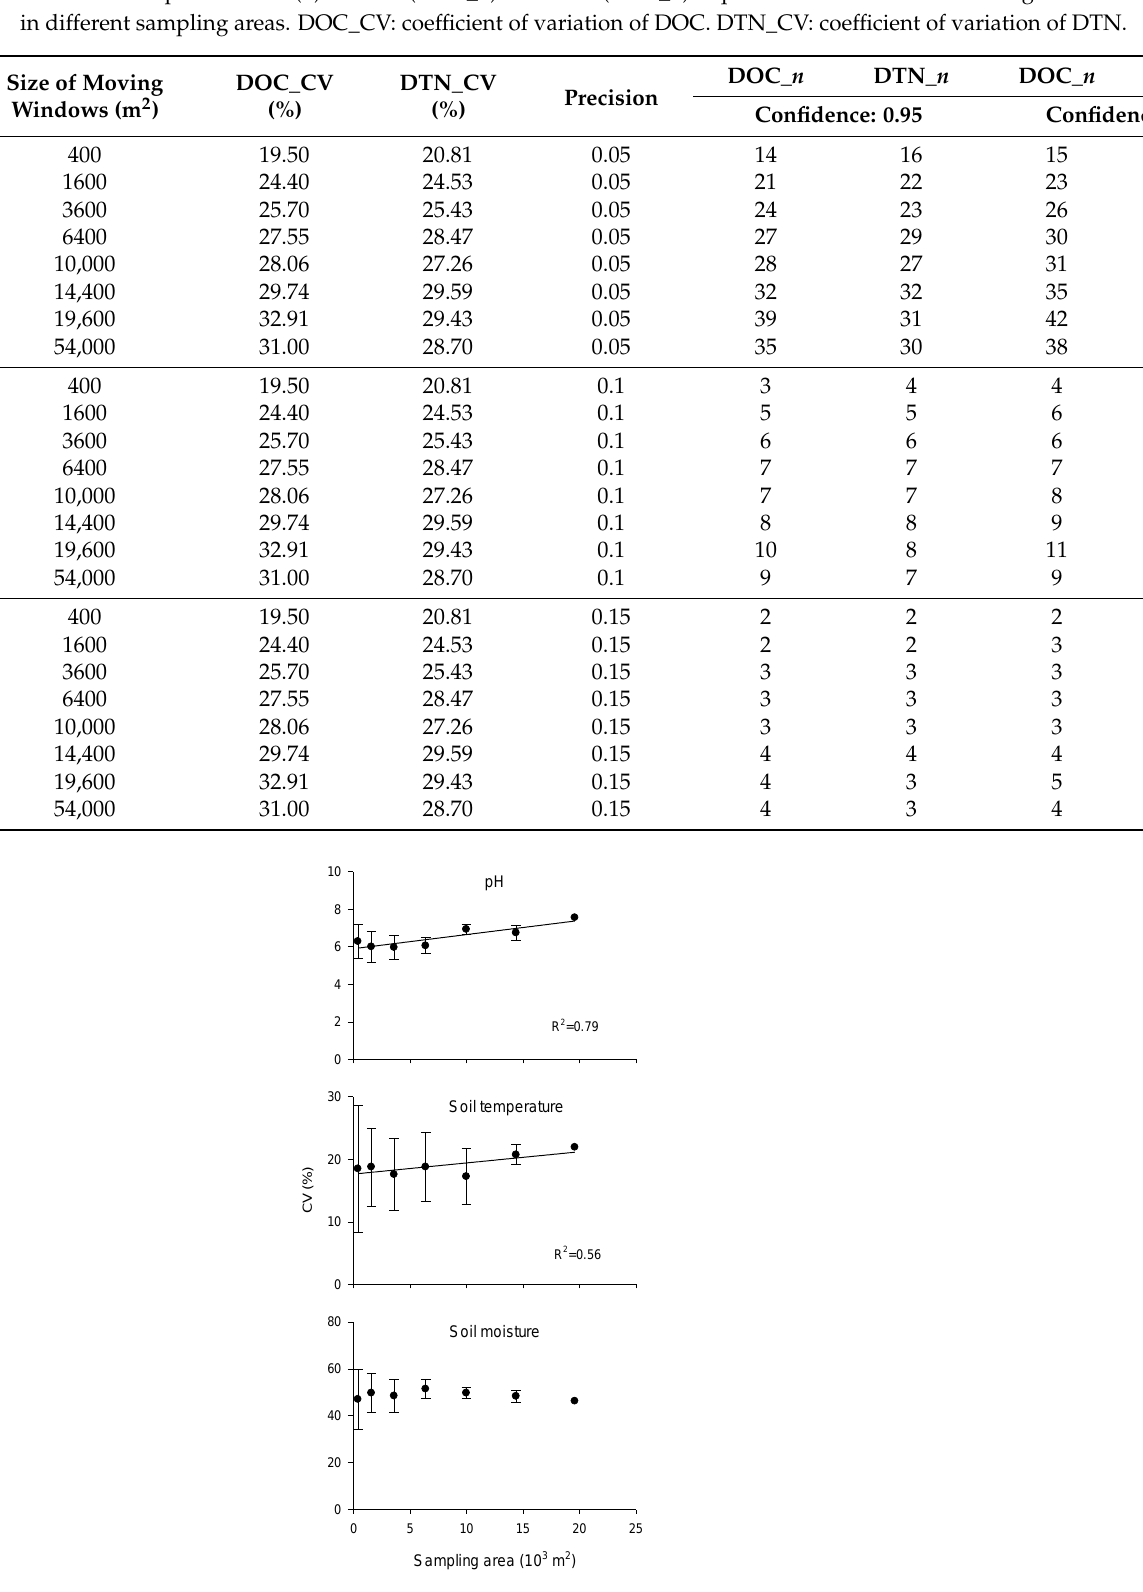
Figure A1. Relationship between the CV of pH, soil temperature, and moisture with increasing sampling areas. Error bars represent the standard error of the